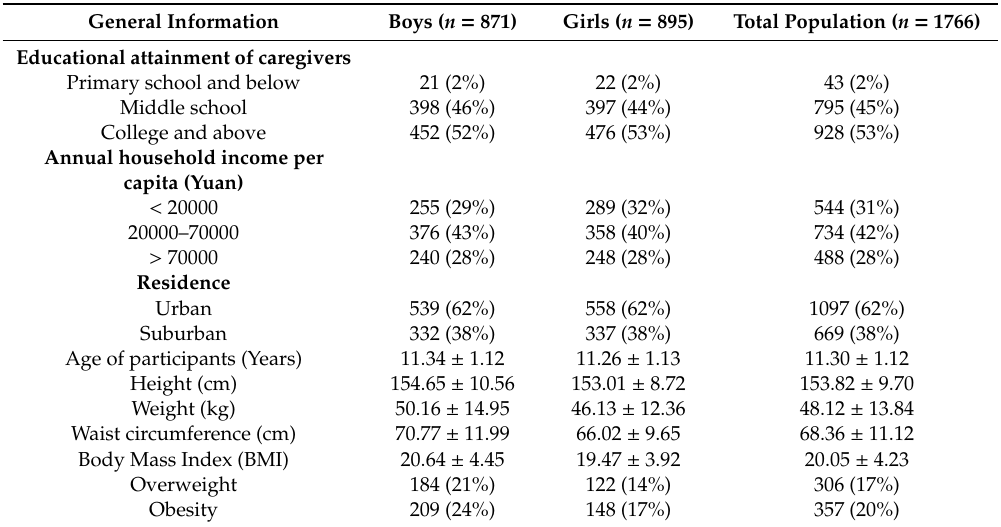
Table 1. Characteristics of participants.